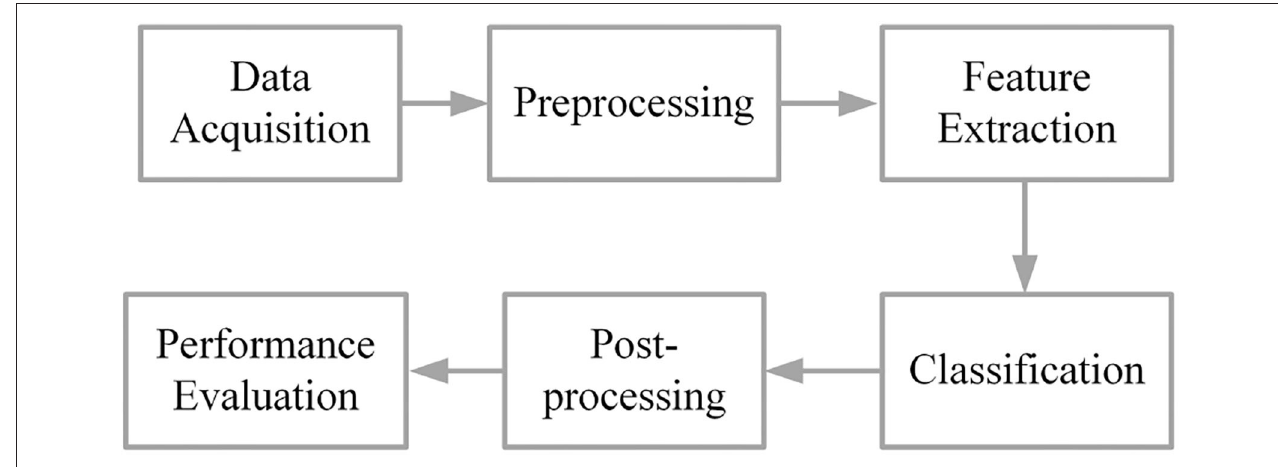
FIGURE 2 | The six stages of the standard structure of the